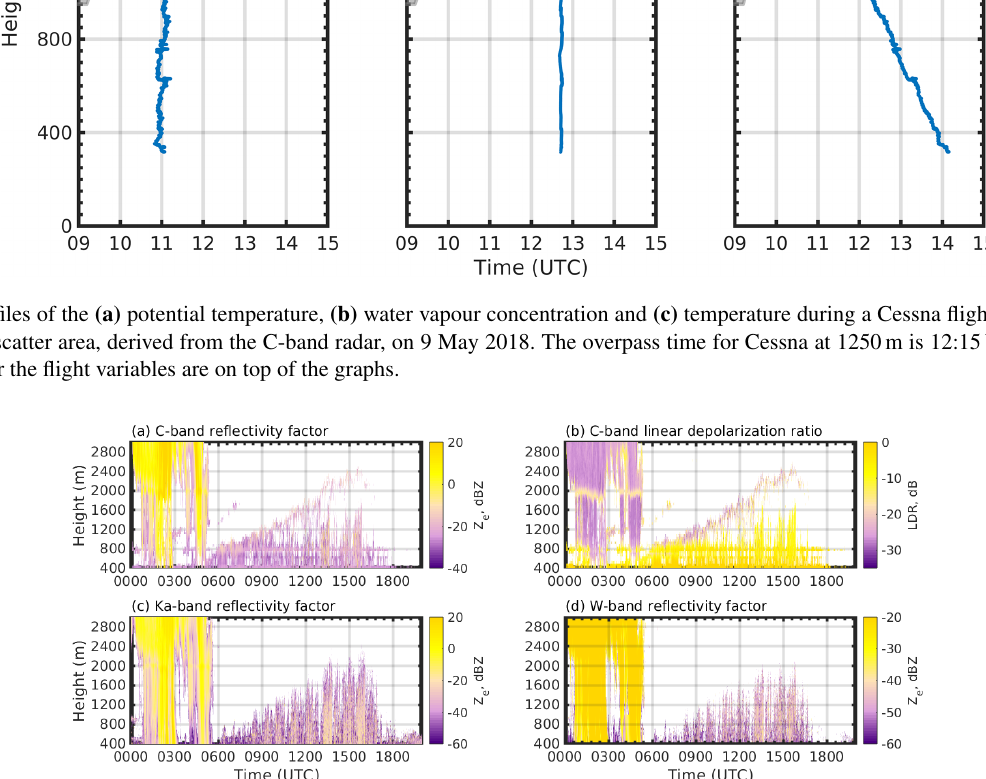
Figure 8. The 1min averaged radar returns for 18 May 2018 in Hyytiälä, for (a) the C-band reflectivity factor, (b) the C-band linear depolarization ratio, (c) the Ka-band reflectivity factor and (d) the W-band reflectivity factor. Clouds and precipitation are seen during the night until